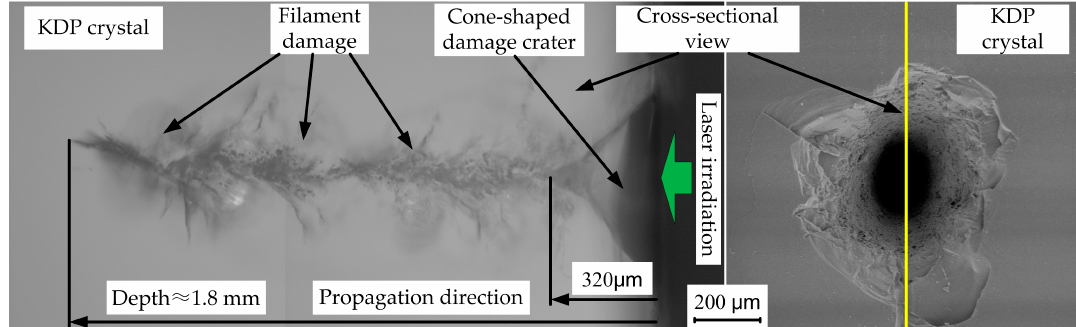
Figure 10. Cross-sectional view of a typical damage crater on processed KDP surface.